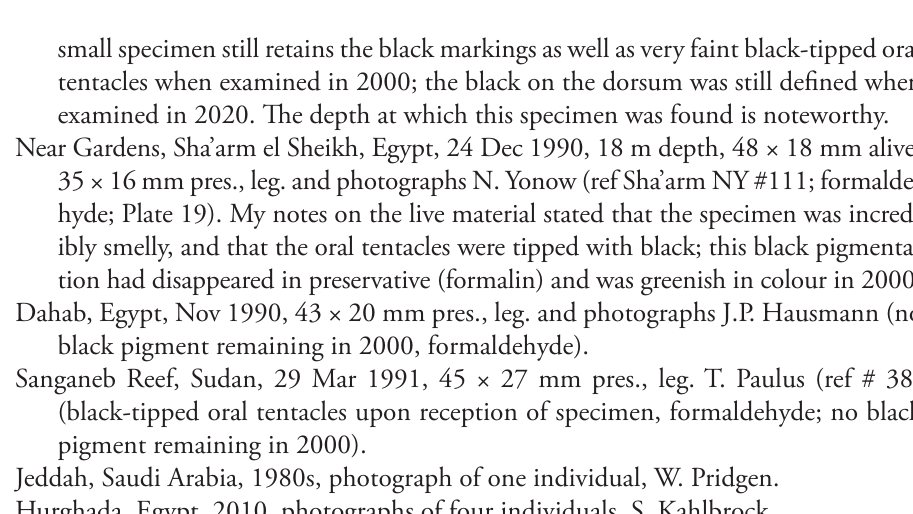
Figure A1. Phyllidiopsis sinaiensis , photograph of preserved specimen collected by the ‘Meteor’ expe- dition at 214–237 meters depth. Anus visible to the right of the photograph, at the narrowing of the longitudinal black